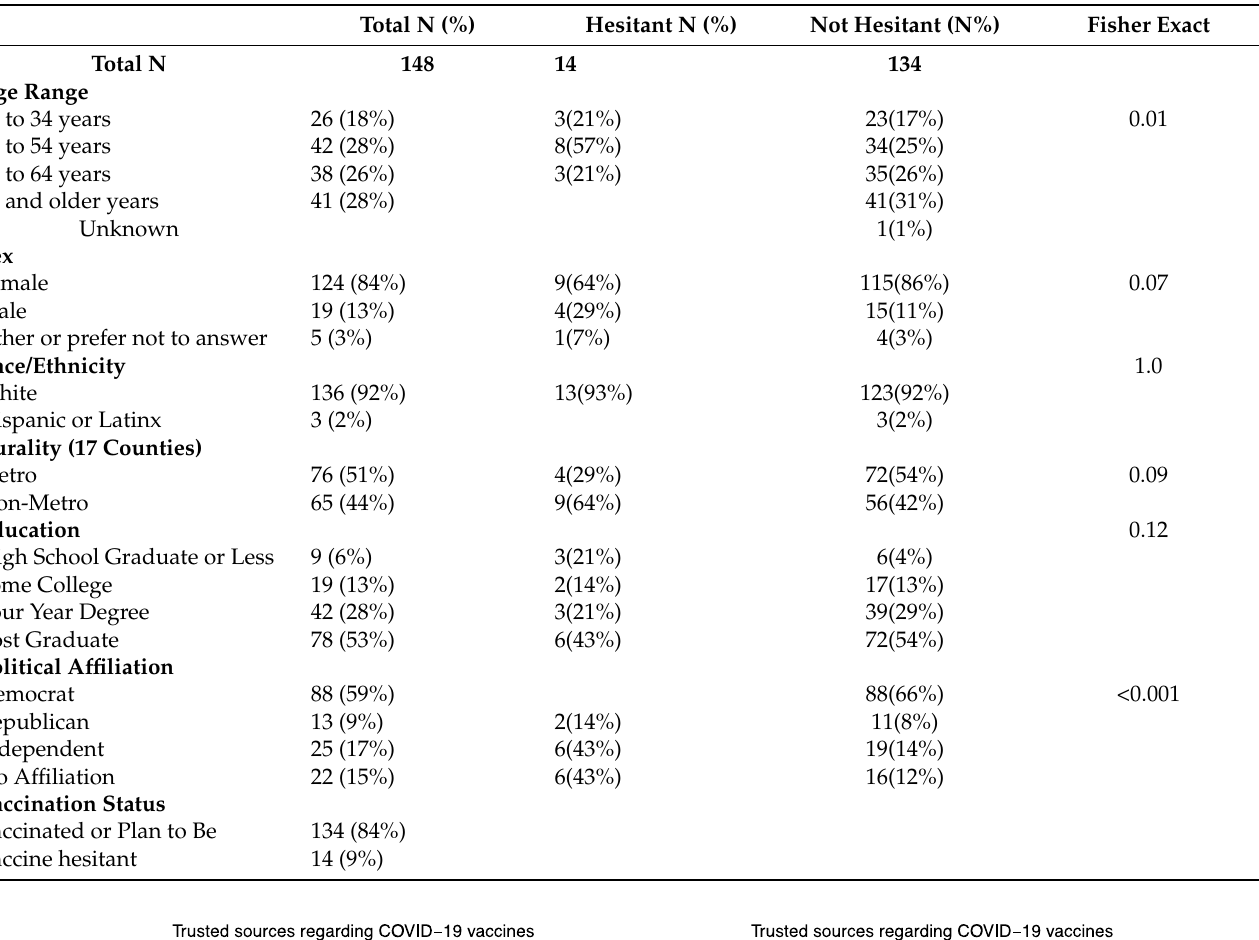
Table 1. Characteristics of Survey Participants and Comparison Hesitant and Not Hesitant Group Characteristics ( N = 148).